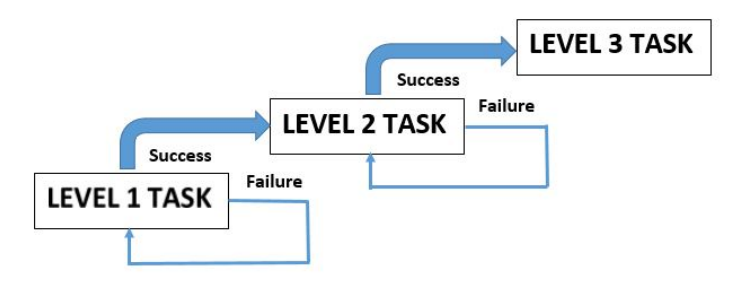
Figure 1. Typical game